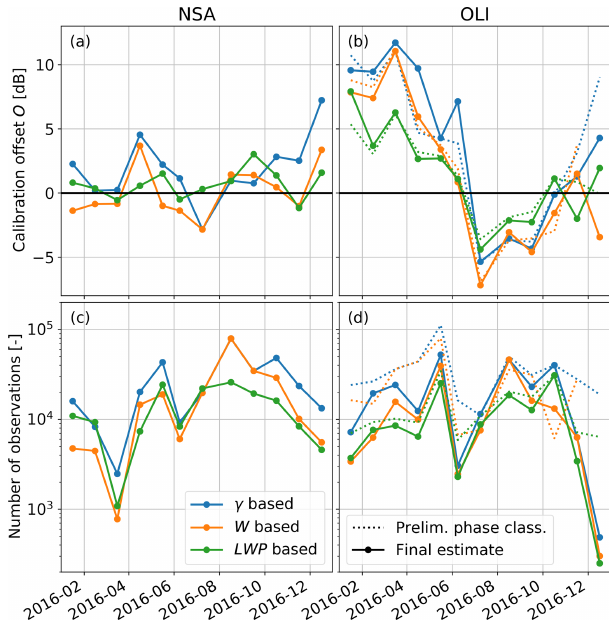
Figure 7. Calibration offsets O (a, b) and number of used observa- tions (c, d) for NSA (a, c) and OLI (b, d) . For OLI, the dotted lines show the preliminary results without modifying the phase classifi- cation with O phaseclass